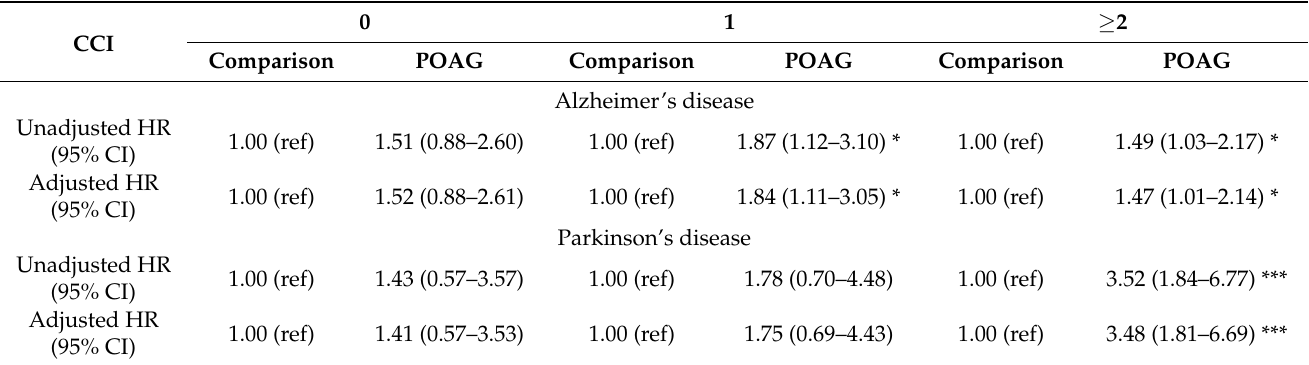
Table 6. Risk of Alzheimer’s disease and Parkinson’s disease in POAG patients according to the